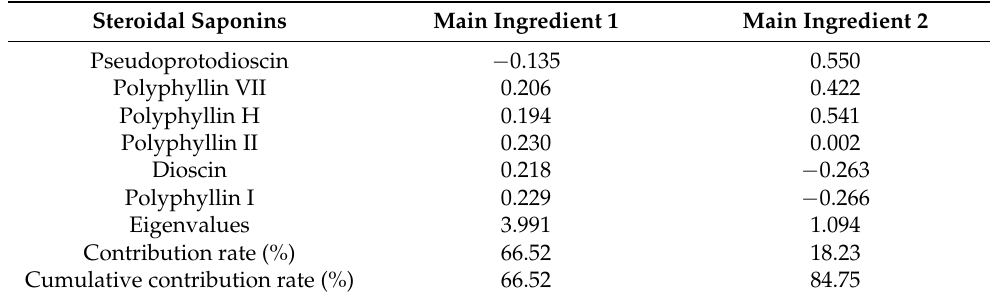
Table 6. Principal Component Analysis Matrix of Steroidal Saponins in Paris polyphylla var. yunnanensis .